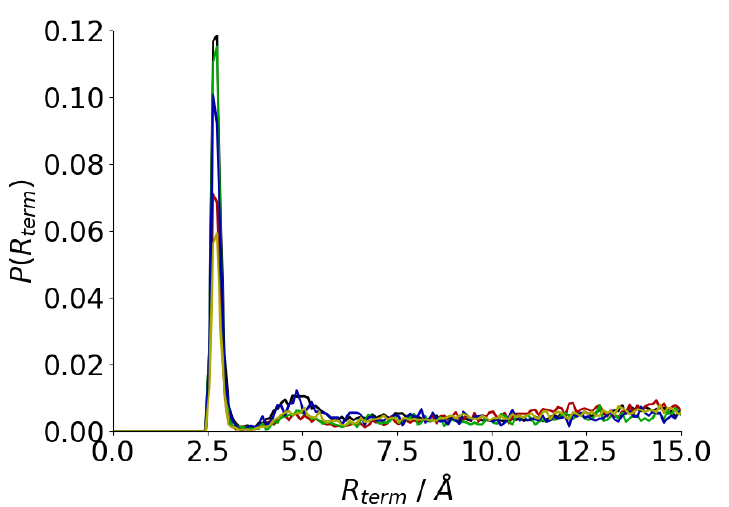
Figure 5. Histogram of separation between termini ( R term ) for Au111 (black), Au100 (red), Ag111 (green), Ag100 (blue) surfaces, and bulk solution